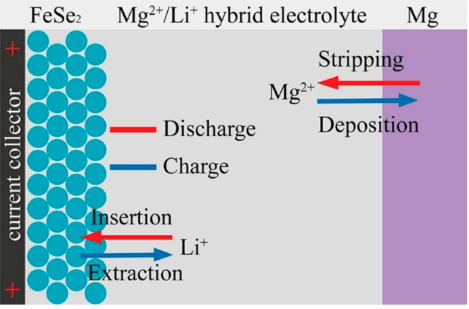
Figure 5. Schematic of the working mechanism of the FeSe 2 | Mg 2 + / Li + | Mg